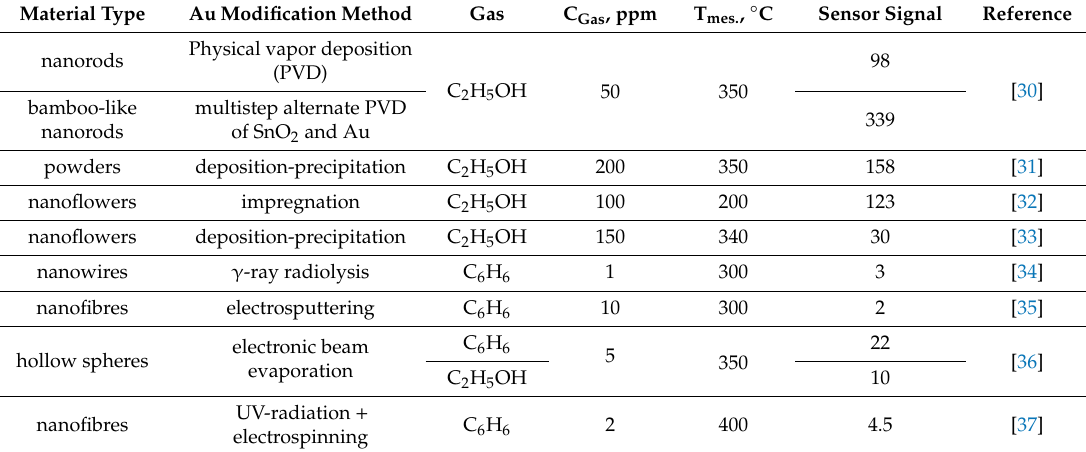
Table 1. Sensor properties of Au-modified SnO 2 sensor materials towards the detection of ethanol and